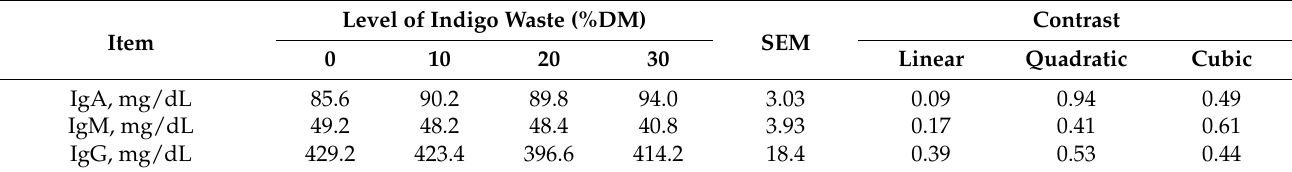
Table 9. Effect of indigo waste on immune response in growing beef